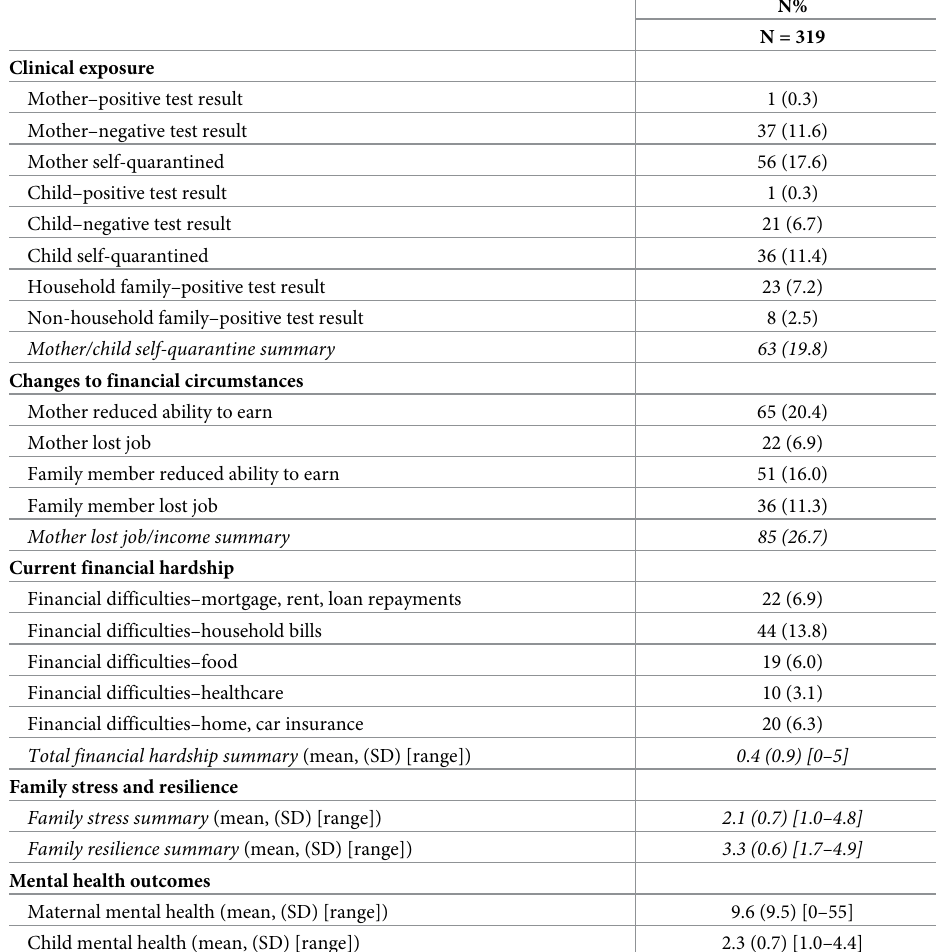
Table 3. Summary data of COVID-19 impacts (individual items and summary measures) and mental health